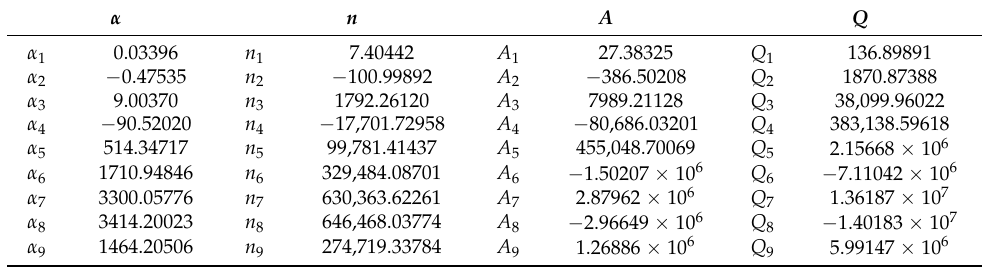
Figure 6. Linear fitting relationships at strain = 0.3: ( a ) ln[sinh( ασ )]~ln